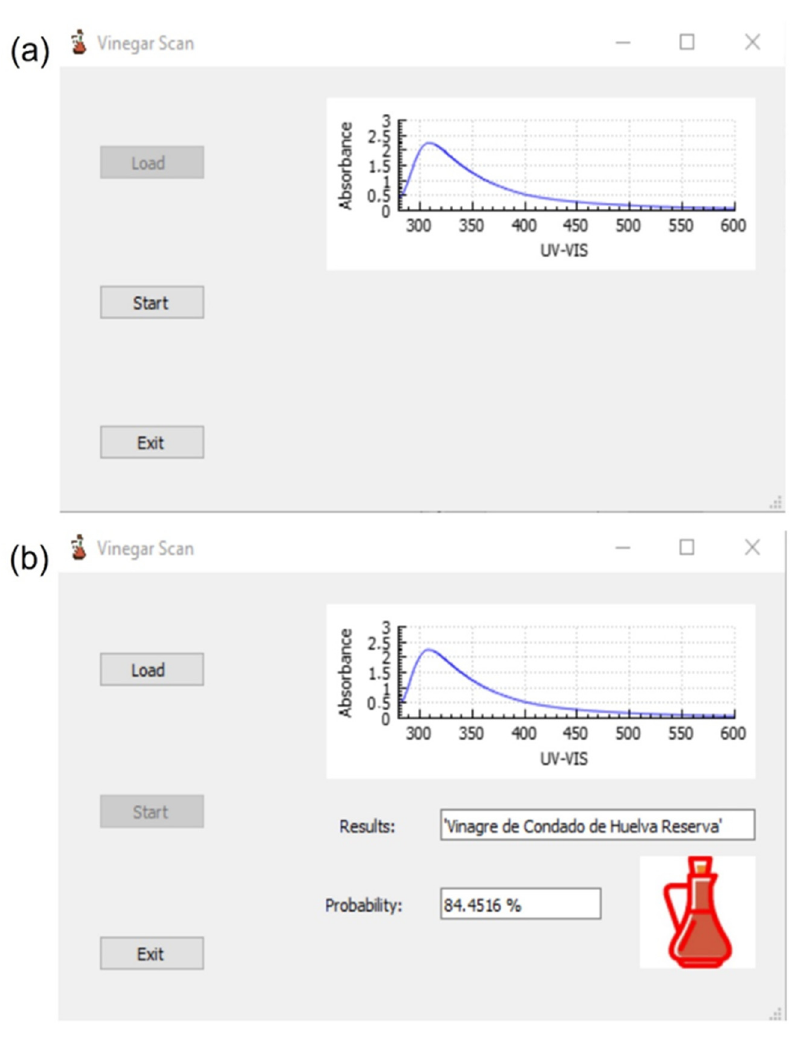
Figure 6. Screens of the VinegarScan GUI: ( a ) screen once the spectrum has been loaded; ( b ) screen once the analysis has been performed by pressing the Start button.